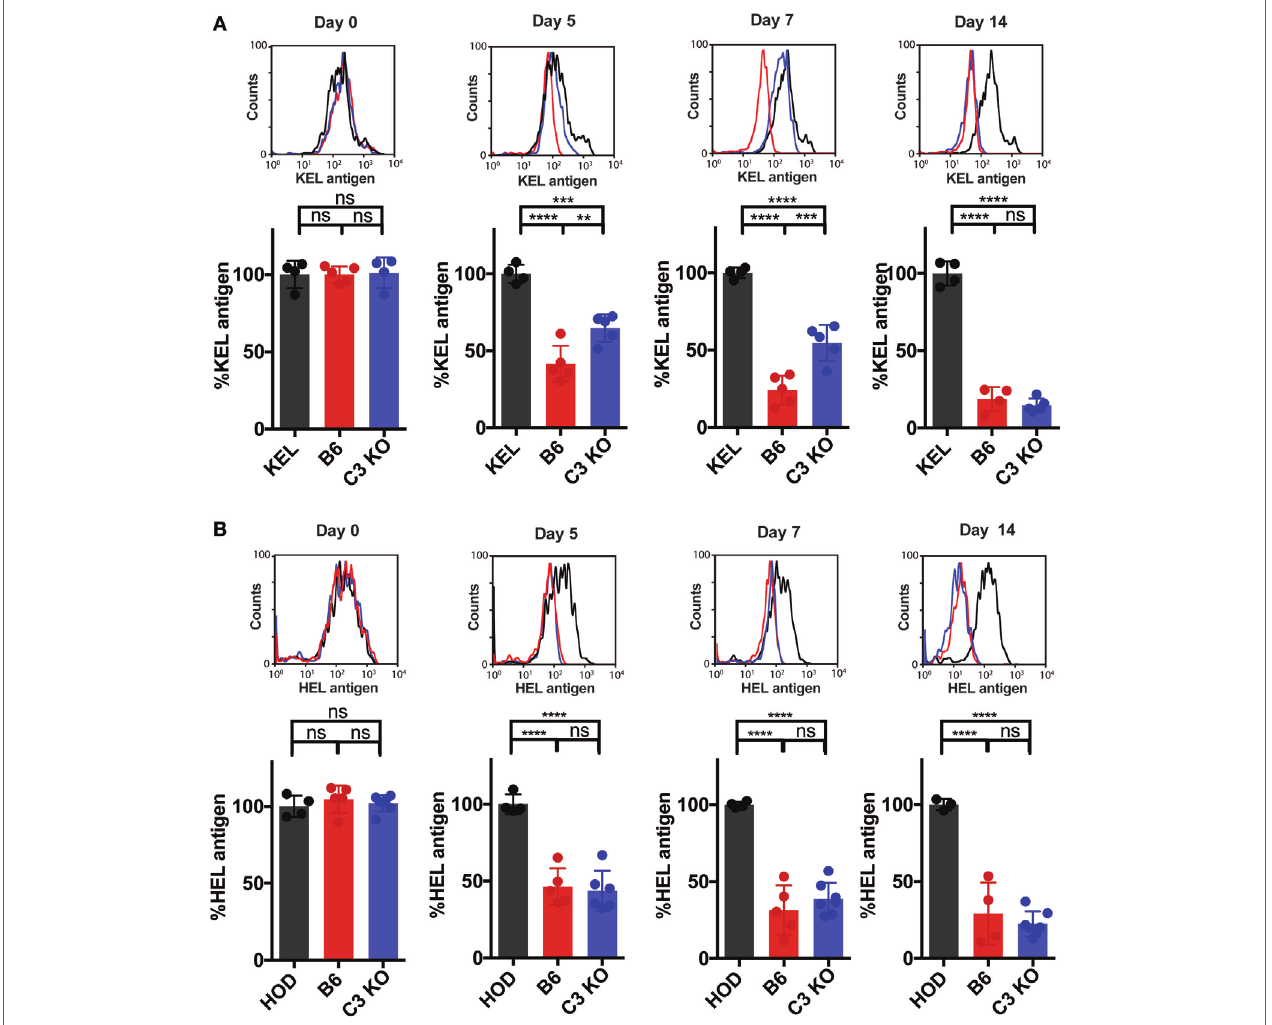
FigUre 5 | Complement component 3 (C3) accelerates loss of detectable KEL antigen on KEL red blood cells (RBCs) over time. (a,B) B6 or C3 KO recipients were transfused with either DiI-labeled KEL RBCs or DiI-labeled HOD RBCs with control DiO-labeled antigen-negative RBCs. As a control, KEL mice were transfused with syngeneic DiI-labeled KEL RBCs or HOD mice were transfused with syngeneic DiI-labeled HOD RBCs, each with control DiO-labeled antigen-negative RBCs. (a) Post-transfusion, DiI-labeled KEL RBCs were stained for the level of detectable KEL antigen using anti-KEL polyclonal antibody (Ab). Level of detectable KEL antigen was measured as a percentage of KEL antigen normalized to the level of detectable KEL antigen in KEL mice transfused with syngeneic DiI-KEL RBCs, shown at days 0, 5, 7, and 14 post-transfusion. (B) Post-transfusion, DiI-labeled HOD RBCs were stained for the level of detectable hen egg lysozyme (HEL) antigen using polyclonal anti-HEL Ab. Level of detectable HEL antigen was measured as a percentage of HEL antigen normalized to the level of detectable HEL antigen in HOD mice transfused with syngeneic DiI-HOD RBCs. (a,B) **** p < 0.0001, *** p < 0.0008, ** p < 0.007 and ns = not significant. Means ± SD